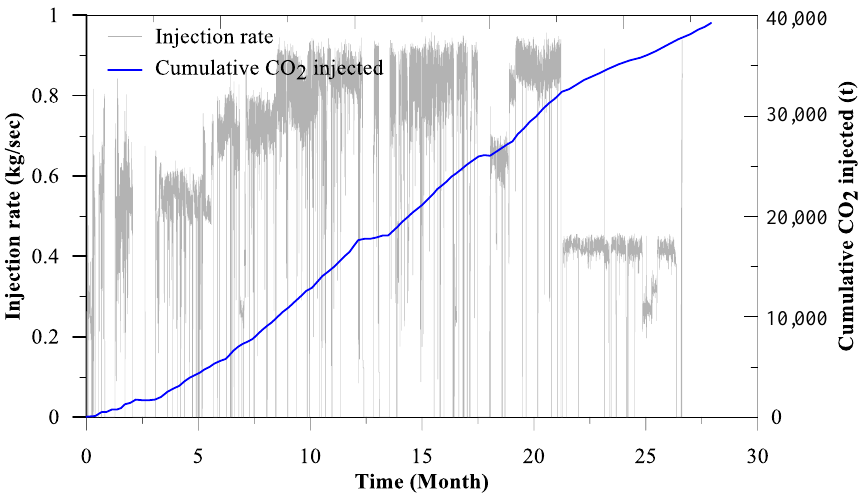
Figure 1. Injection rate and cumulative CO 2 injection (Liebscher et al. [40], Kempka and Kühn [20], data also available in https://github.com/ufz/ogs5-benchmarks).